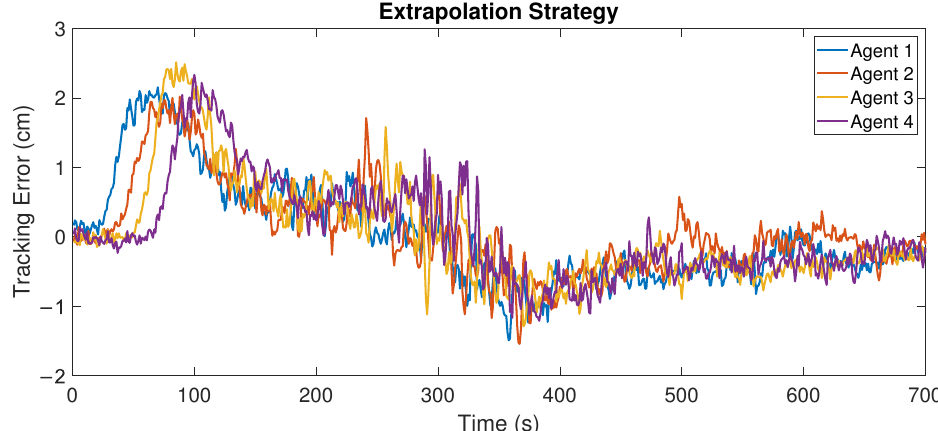
Figure 26. Mean ¯ ζ i ( k ) of 8 trials of the tracking error using the extrapolation strategy with a mov- ing